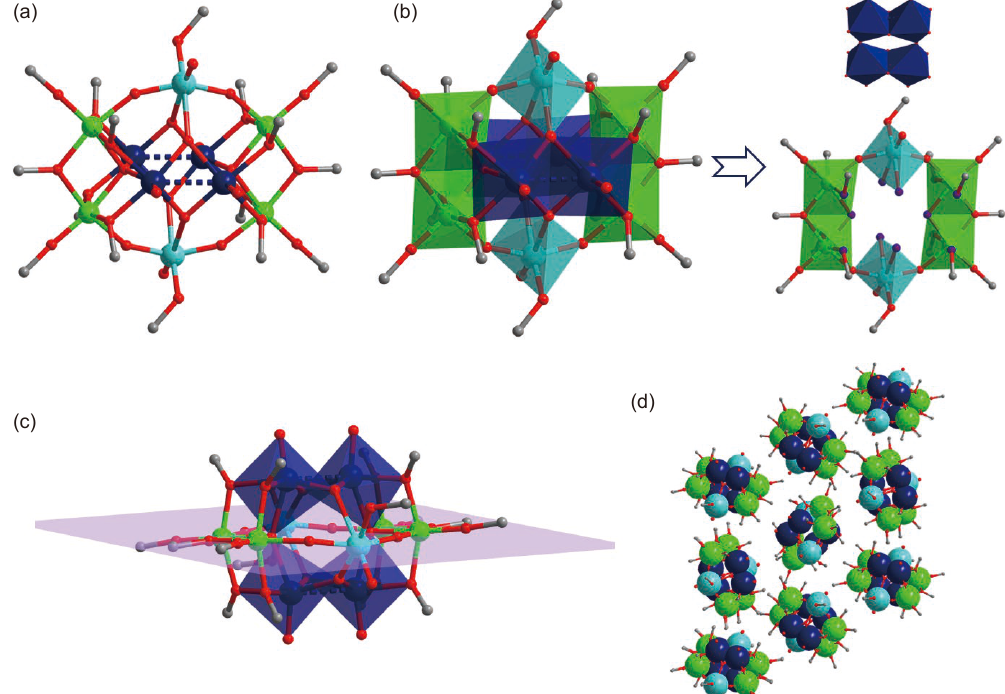
Figure 1 Molecular structures of 1 in (a) a ball stick and (b) polyhedral models, respectively. (c) Relative position of the decorated species as a central {Mo 4 } moiety for 1 . (d) Packing view of 1 along the a-axis. Color code: green: Ti; navy: Mo V ; aqua: Mo VI ; red: O; gray: C; green: octahedra TiO 6 ; navy: octahedra Mo V O 6 ; and aqua: octahedra Mo VI O 6 . All H atoms were omitted for